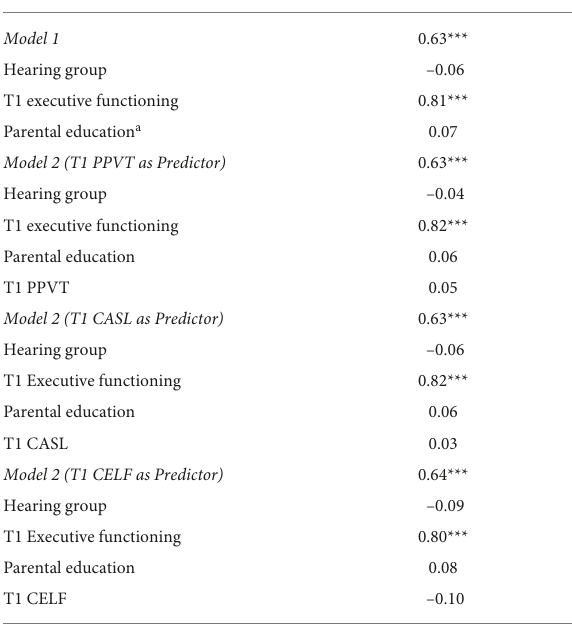
TABLE 5 Hierarchical linear regressions predicting T2 executive